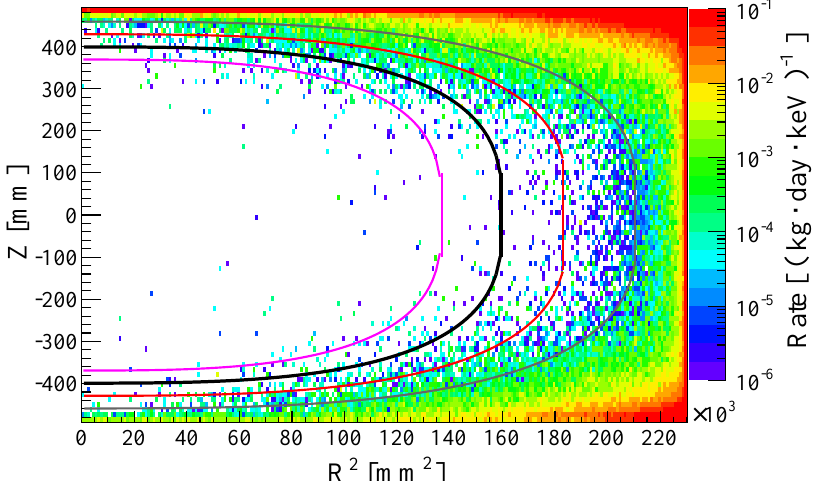
Figure 2. Simulation of background events originating from detector’s materials radioactivity in XENON1T. The spatial distribution inside the active volume of the TPC is shown as a 2D histogram. The contours indicate progressively smaller super-ellipsoid inner fiducial volumes where the total background rate is largely suppressed with respect to the outermost layers of the TPC. The highly- efficient self-shielding extends also to external neutron sources. Image from Ref.